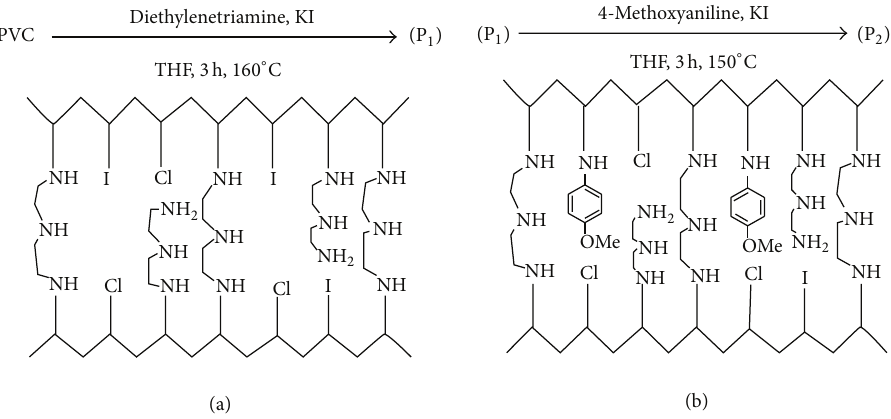
Scheme 1: Structures of (a) amino-PVC (P 1 ) and (b) amino-p-anisidine-PVC (P 2 ).